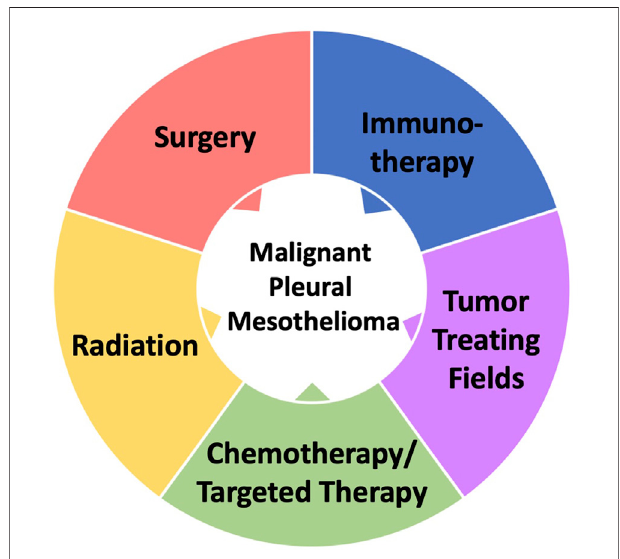
FIGURE 1 | Modalities of MPM